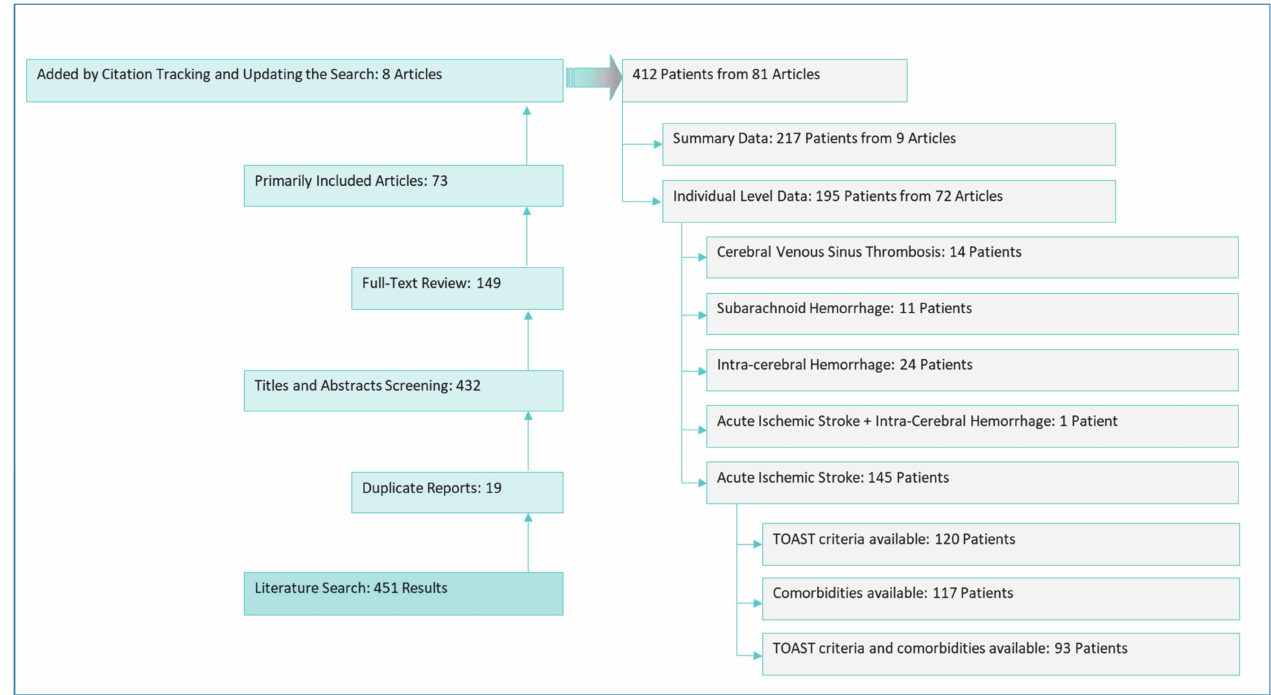
Figure 1. The process of literature review and main